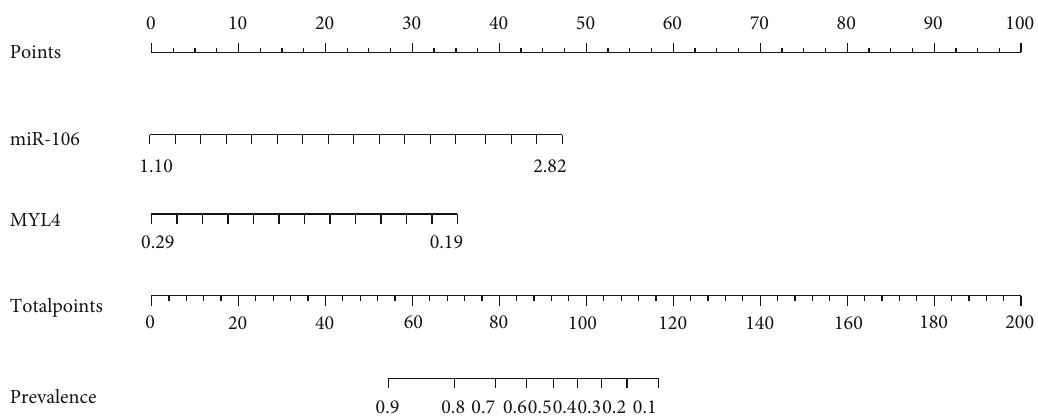
Figure 3: Nomogram of the relationship between miR-106, MYL4 and the prevalence of